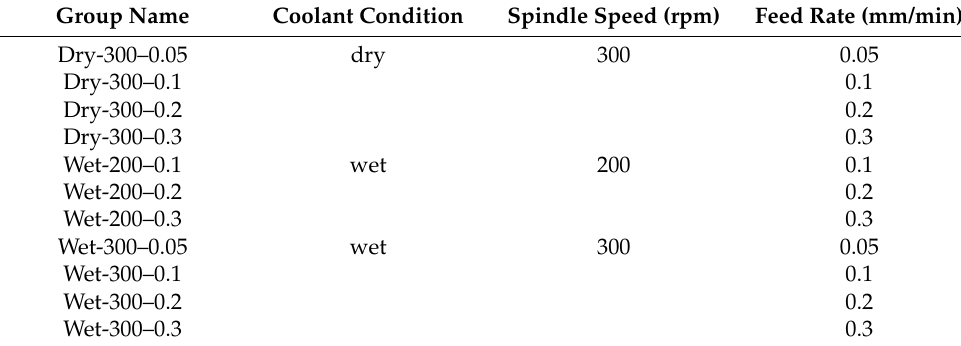
Table 1. The cutting